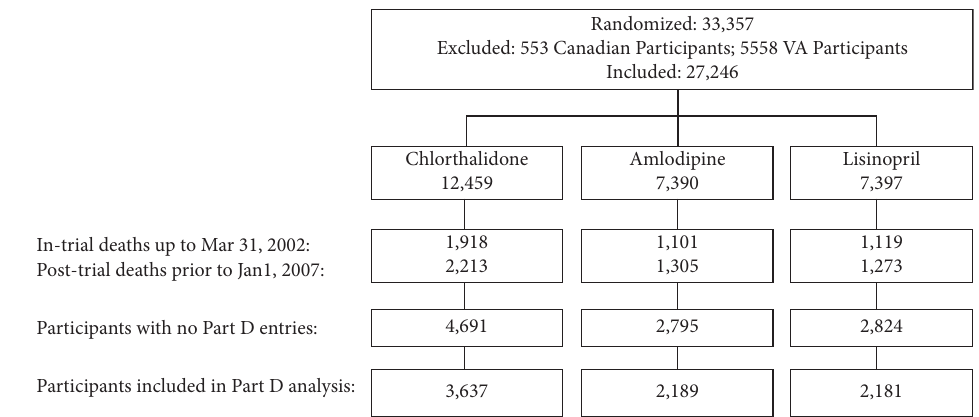
Figure 1: Study participant inclusion and exclusion and number of subjects in the final